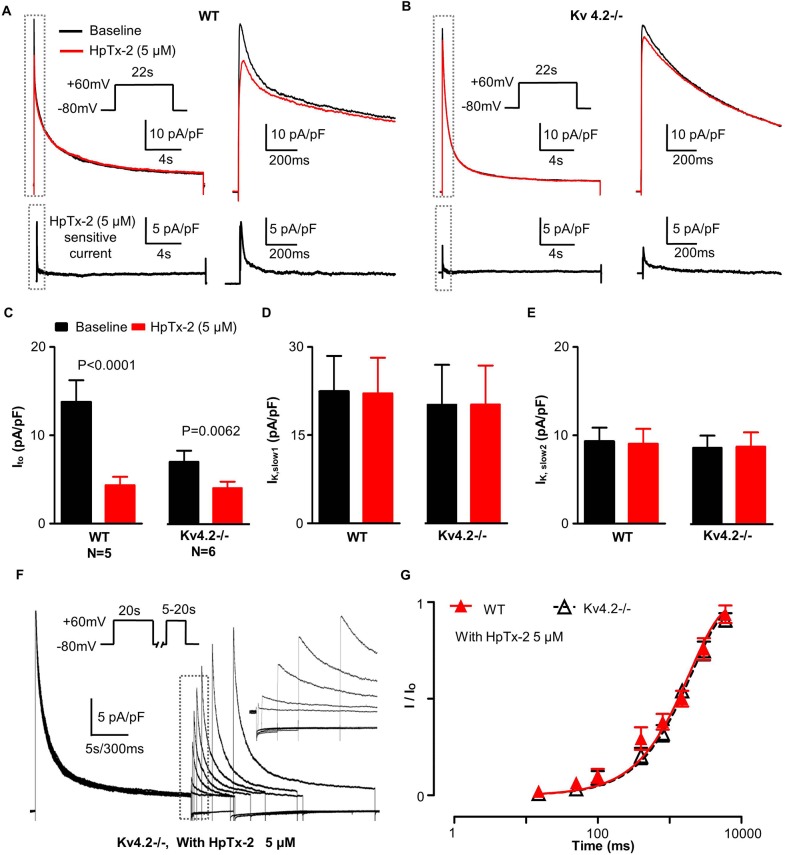
Effect of HpTx-2 on K+ current from isolated WT and Kv4.2-/- cardiomyocyte.(A) This panel illustrates representative K+ current traces recorded from isolated WT cardiomyocyte under baseline (dark) conditions and after the addition of 5 μM HpTx-2 (red), a high-selective Kv4.x channel blocker. The HpTx-2 sensitive current was obtained by arithmetic subtraction of the red trace (with HpTx-2) from the dark trace (baseline) control and is shown in the lower trace. The initial parts of traces (gray dashed box) are shown on a more rapid time scale on their right side. (B) Shows representative K+ current traces from a Kv4.2-/- cardiomyocyte under baseline (dark) conditions and after the addition of 5 μM HpTx-2 (red). The HpTx-2 sensitive currents are shown in the lower trace. (C) Show here is the Ito current density estimated under both baseline conditions and after HpTx-2 treatment from the tri-exponential curve fits to the K+ currents recorded (as described in Fig 1). Note that while HpTx-2 decreased the Ito current in both WT and Kv4.2-/-, the decrease was far greater (P<0.01) in WT than the Kv4.2-/- cardiomyocytes. (D) and (E) These panels show IK, slow1 and IK, slow2 current density estimated (using the curve fitting methods) under baseline conditions and after HpTx-2 addition. After HpTx-2 these two currents density remained fixed and did not differ between WT and Kv4.2-/- cardiomyocytes. (F) Shows representative K+ current recovery from inactivation recordings from a typical Kv4.2-/- cardiomyocyte with 5 μM HpTx-2. See Methods for the specific protocol. The early portions of traces following the depolarizing test-pulse are re-shown on a faster (expanded to 300 ms/bar scale) time scale in the inset (broken box) to better illustrate the properties of the time-course (of the recovery) of the peaks of the Ito K+ currents as a result of membrane repolarization (to -80mV). (G) This panel shows the normalized Ito current as a function of the pulse interval duration during the recovery from inactivation protocol with 5 μM HpTx-2. The normalized current is defined as the amplitude of the Ito density (i.e. the fastest component) estimated from fits to the currents elicited following depolarization during the recovery period (as described in Fig 1) divided by the Ito density (i.e. fastest component) estimated from fits of the current measured following depolarization during the initial conditioning pulse. Notice that, the recovery of Ito in both WT and Kv4.2-/- here are similar and are best fit with mono-exponential equation without the fast recovery component (that is, Ito,f) showed in Fig 2B. Moreover, they were comparable to the slow components (that is, Ito,s) dissected in Fig 2B without HpTx-2.